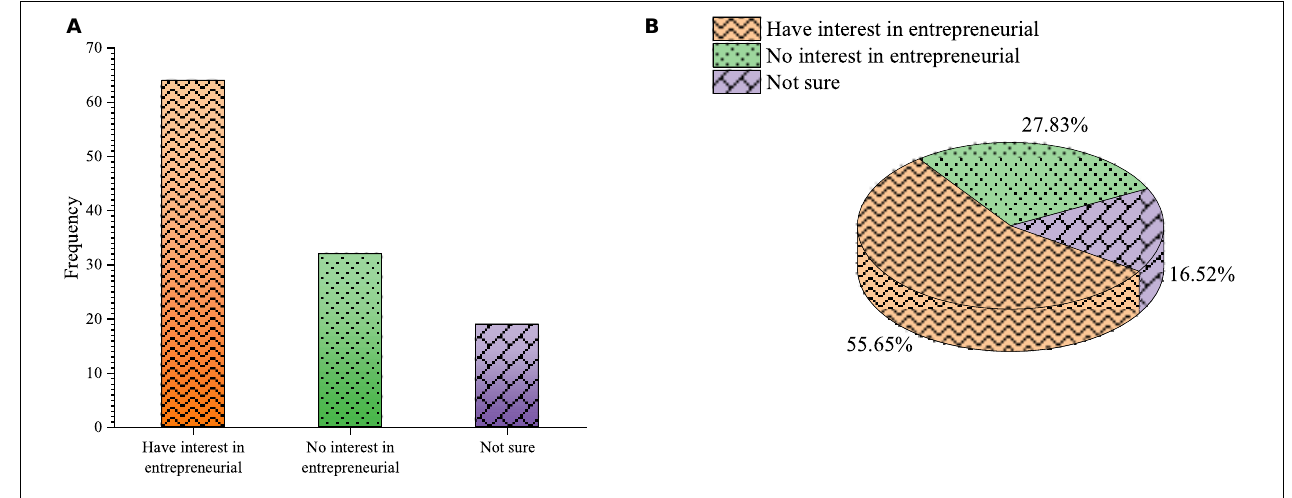
FIGURE 5 | College students’ attitude toward entrepreneurial interest (A) frequency (B)